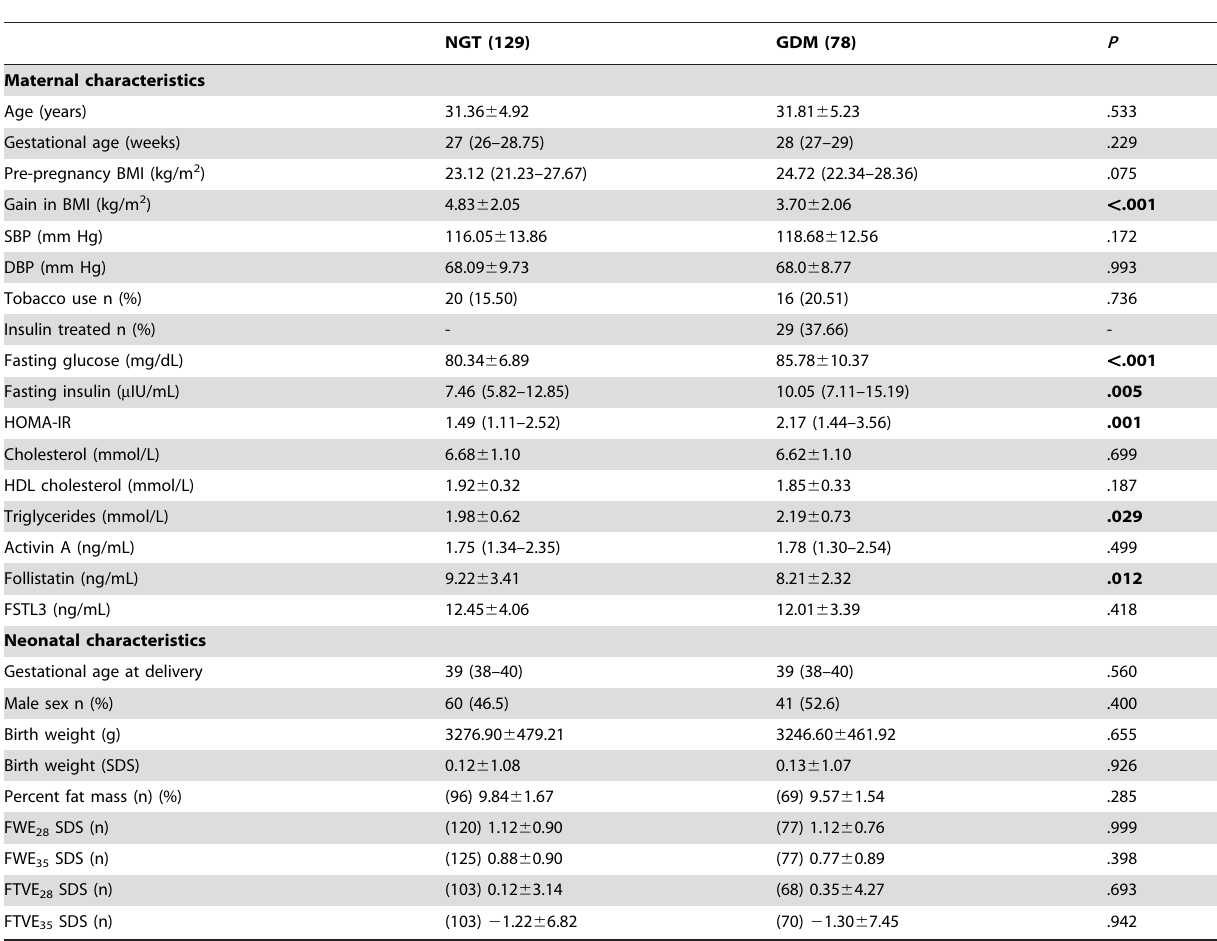
Table 1. Clinical, metabolic and ultrasound characteristics of the population